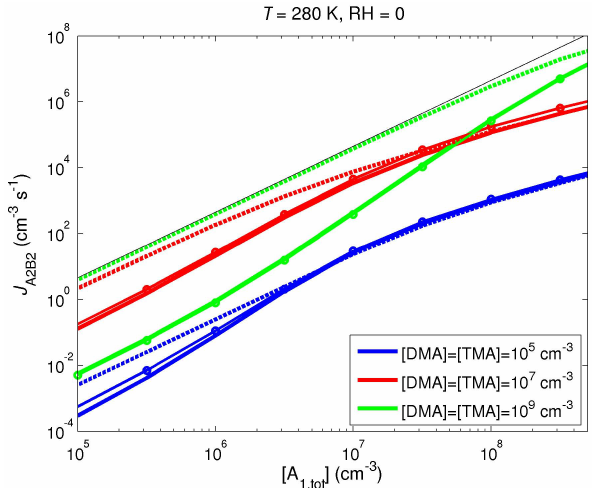
Fig. 3. The modelled formation rates J A2T2 (solid lines), J A2D2 (dashed lines) and J A2D1T1 (solid lines with circles) as a func- tion of the modelled total sulphuric acid monomer concentration [A 1 , tot ] at T = 280 K under varying amine concentration with a 1 : 1 [DMA]:[TMA]-ratio. The solid black line represents the col- lision rate 4.5 × 10 − 10 cm 3 s − 1 · [A 1 , tot ] 2 calculated for all the H 2 SO 4